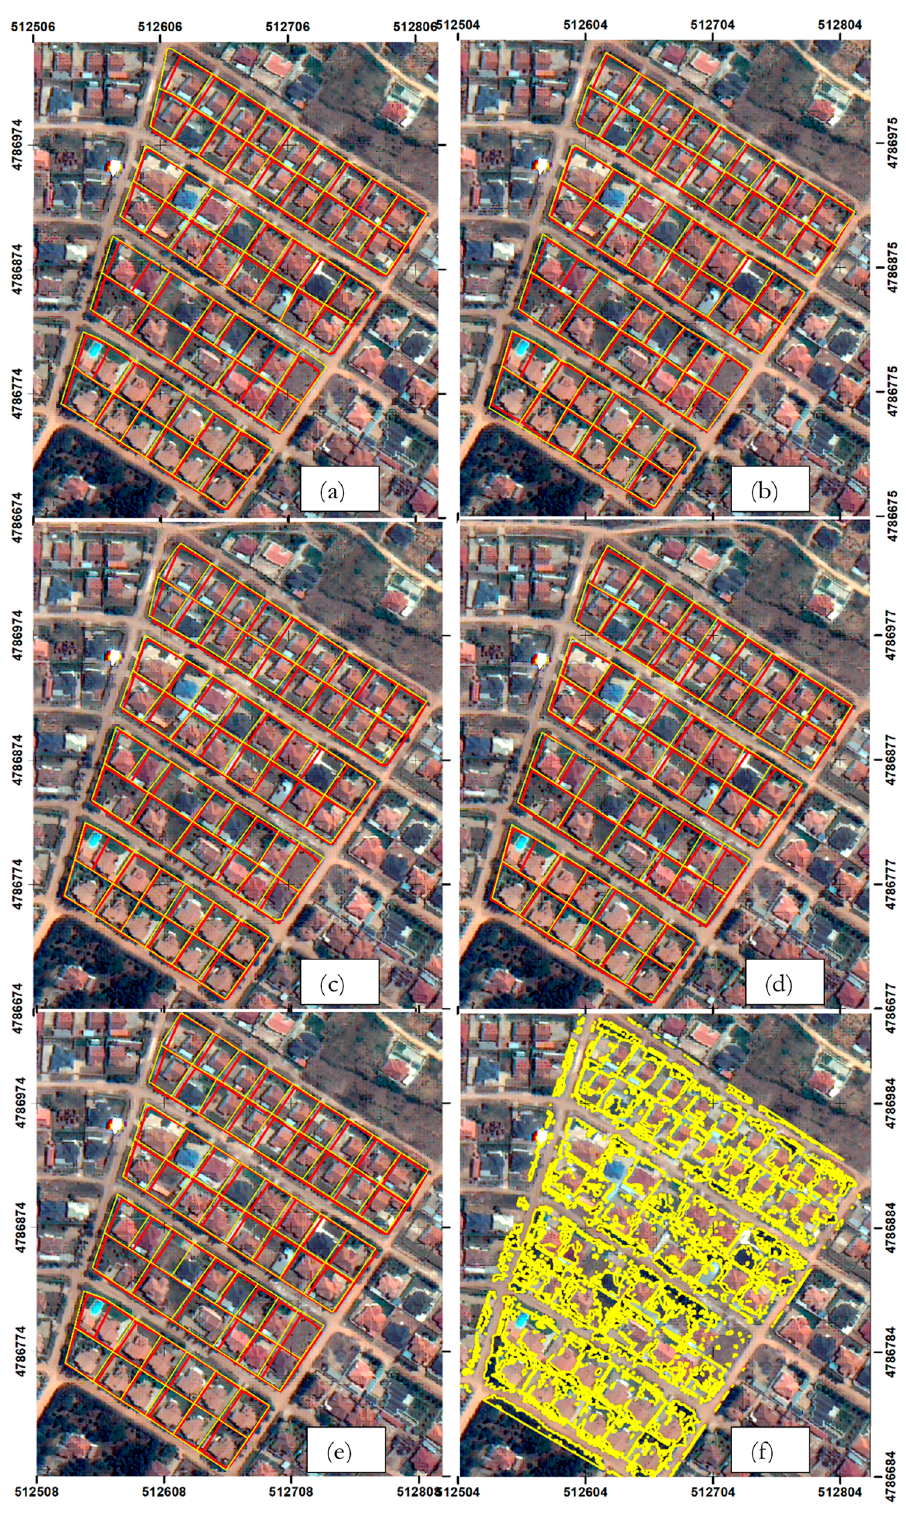
Figure 9. Extracted urban parcels. ( a – e ): manually extracted parcels by five experts. ( f ): automated parcels boundaries